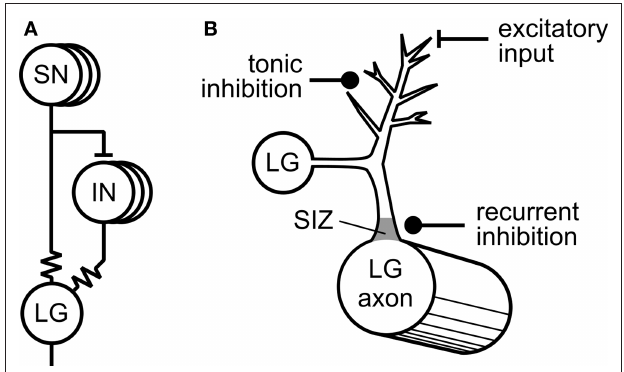
Figure 1 | Tonic inhibition of the crayfish escape system (adapted from edwards et al., 1999 with permission from elsevier). (A) Mechanosensory neurons (SN) directly excite the Lateral Giant (LG) interneuron via an electrotonic synaptic connection (resistor symbol). The SNs also excite mechanosensory interneurons (INS) that are also electrotonically coupled to the LG. (B) Synaptic inputs to the LG. Inhibitory synapses responsible for tonic inhibition are located distally from the LG cell body as are the excitatory synaptic inputs. Synaptic inputs responsible for recurrent inhibition are located proximally to the LG cell body close to the spike initiating zone